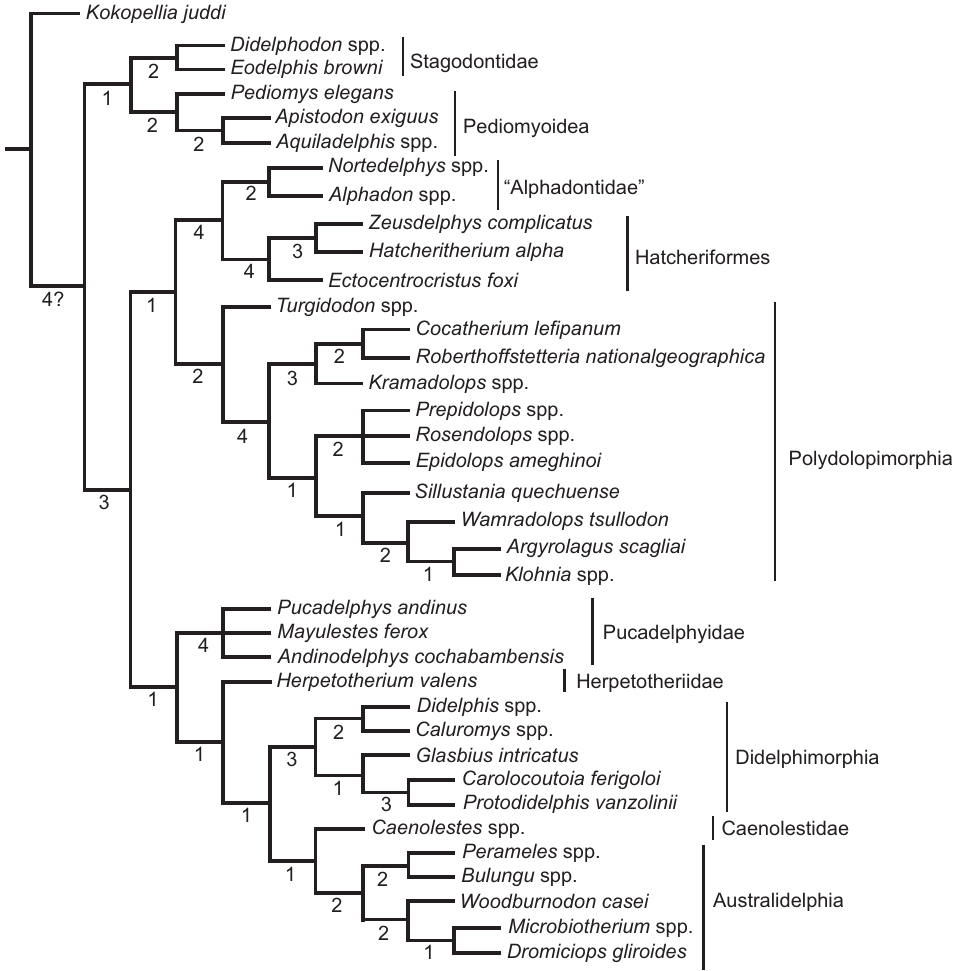
Fig. 2. Single most parsimonious tree found in the phylogenetic analysis. The metatherian lineages are identified by vertical bars. Numbers below the ramus indicate the Bremer